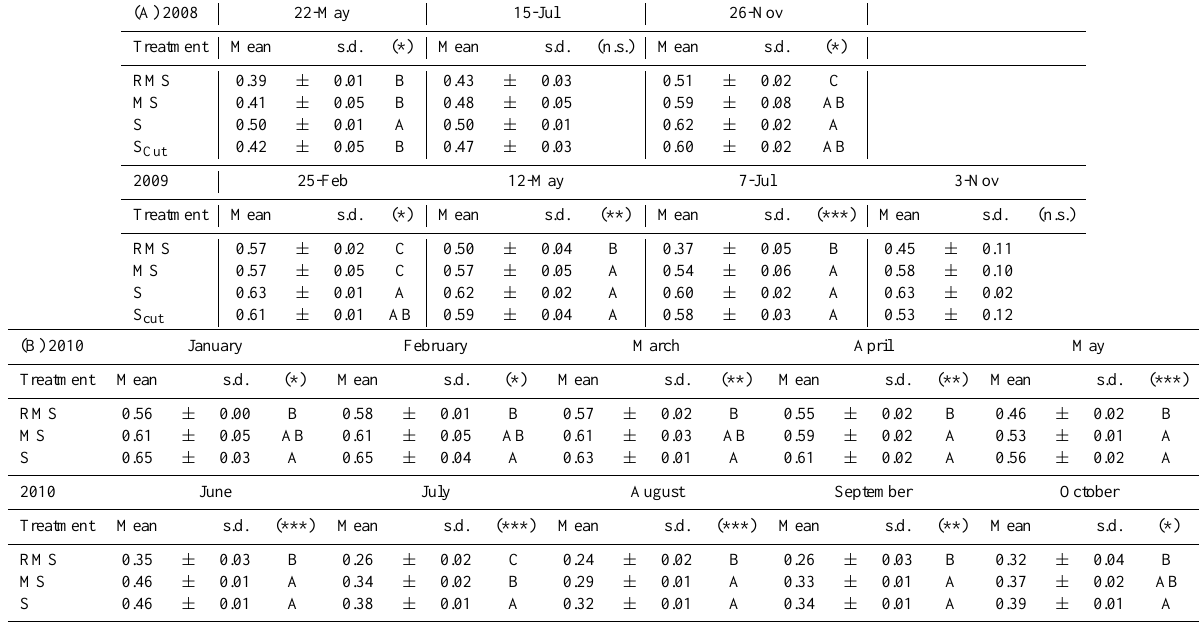
Table 2. Volumetric SMC (% v / v ) measured in each of the four soil collar treatments: surface collar (RMS), mycorrhizal mesh (MS), steel collar (S) and repeatedly cut (S cut ) , during (A) 2008 and 2009 and (B) 2010 with monthly averages from continuous hourly monitoring. Each treatment was replicated ( n = 4) and shown are mean ± s.d.; significant differences between treatments are indicated by different letters, based on a one-way ANOVA (n.s. = not significant; * = P < 0 . 05; ** = P < 0 . 01; *** = P < 0 . 001) and a Tukey’s B post-hoc